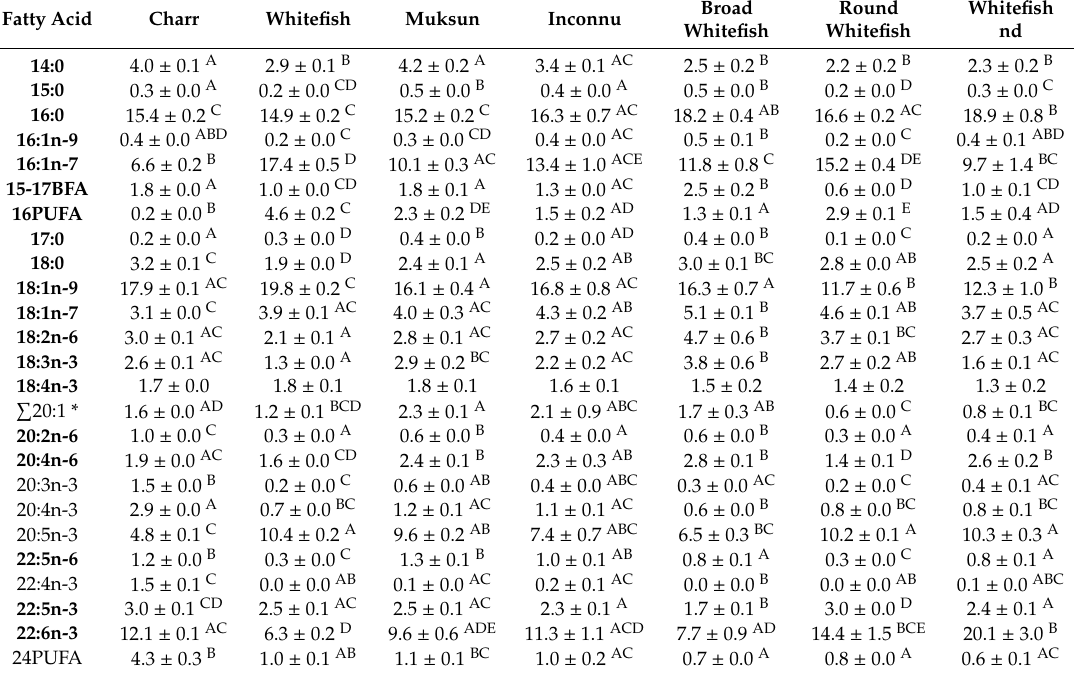
Table 3. Mean levels of fatty acids (% of the total) in total lipids of species of Salmoniformes order: charr— S. drjagini from Sobachye Lake; whitefish— C. lavaretus from Sobachye Lake; muksun— C. muksun from Pyasino Lake; inconnu— S. leucichthys nelma from Pyasino Lake; broad whitefish— C. nasus from Pyasino Lake; round whitefish— P. cylindraceum from Sobachye Lake; whitefish nd—the non-identified form of C. lavaretus from Sobachye Lake. Cases (fatty acids) with normal distribution are given in bold. Means labeled with the same letter are not significantly di ff erent at P < 0.05 after ANOVA post hoc Tukey HSD test (cases with normal distribution) or Kruskal–Wallis test. If ANOVA is insignificant, letters are